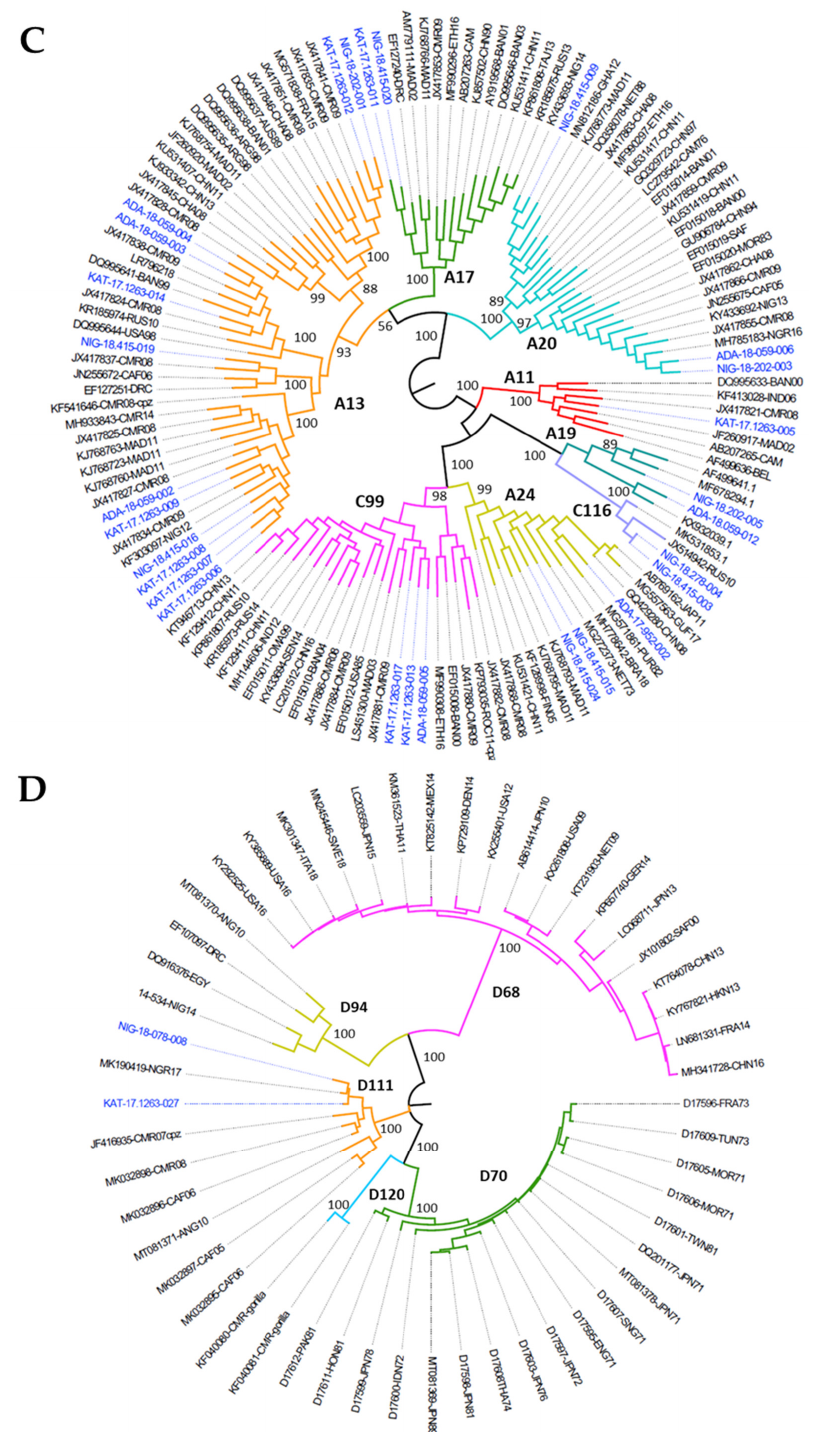
Figure 3. Phylogenetic analysis of VP1 sequences of EV strains from species ( A – D ) (panels A – D in the figure) identified in water samples from Nigeria. Phylogenetic relationships between EV sequences were inferred by using the Maximum Likelihood method and Tamura-Nei model using MEGA X software [29]. Initial tree(s) for the heuristic search were obtained automatically by applying Neighbor-Join and BioNJ algorithms to a matrix of pairwise distances estimated using the Maximum Composite Likelihood (MCL) approach, and then selecting the topology with superior log likelihood value. The tree is drawn to scale, with branch lengths measured in the number of substitutions per site. The percentage of replicate trees in which the associated taxa clustered together in the bootstrap test (1000 replicates) are shown next to the branches. VP1 sequences from Nigerian strains in this study are shown in blue text. Abbreviations for country names are shown in the Abbreviations section at the bottom of the